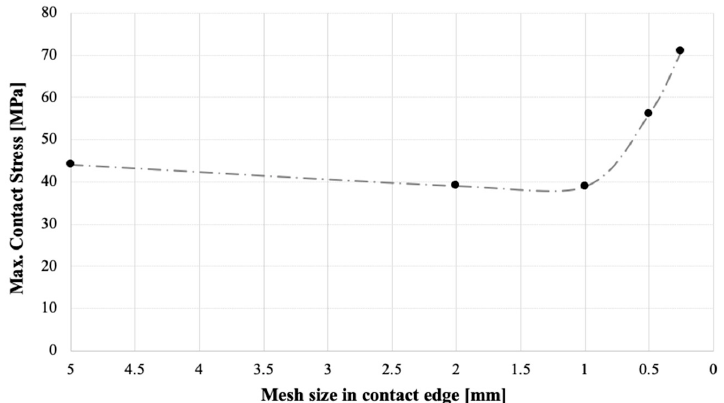
Figure 4. Mesh convergence analysis of PZ9e285(25°) case.